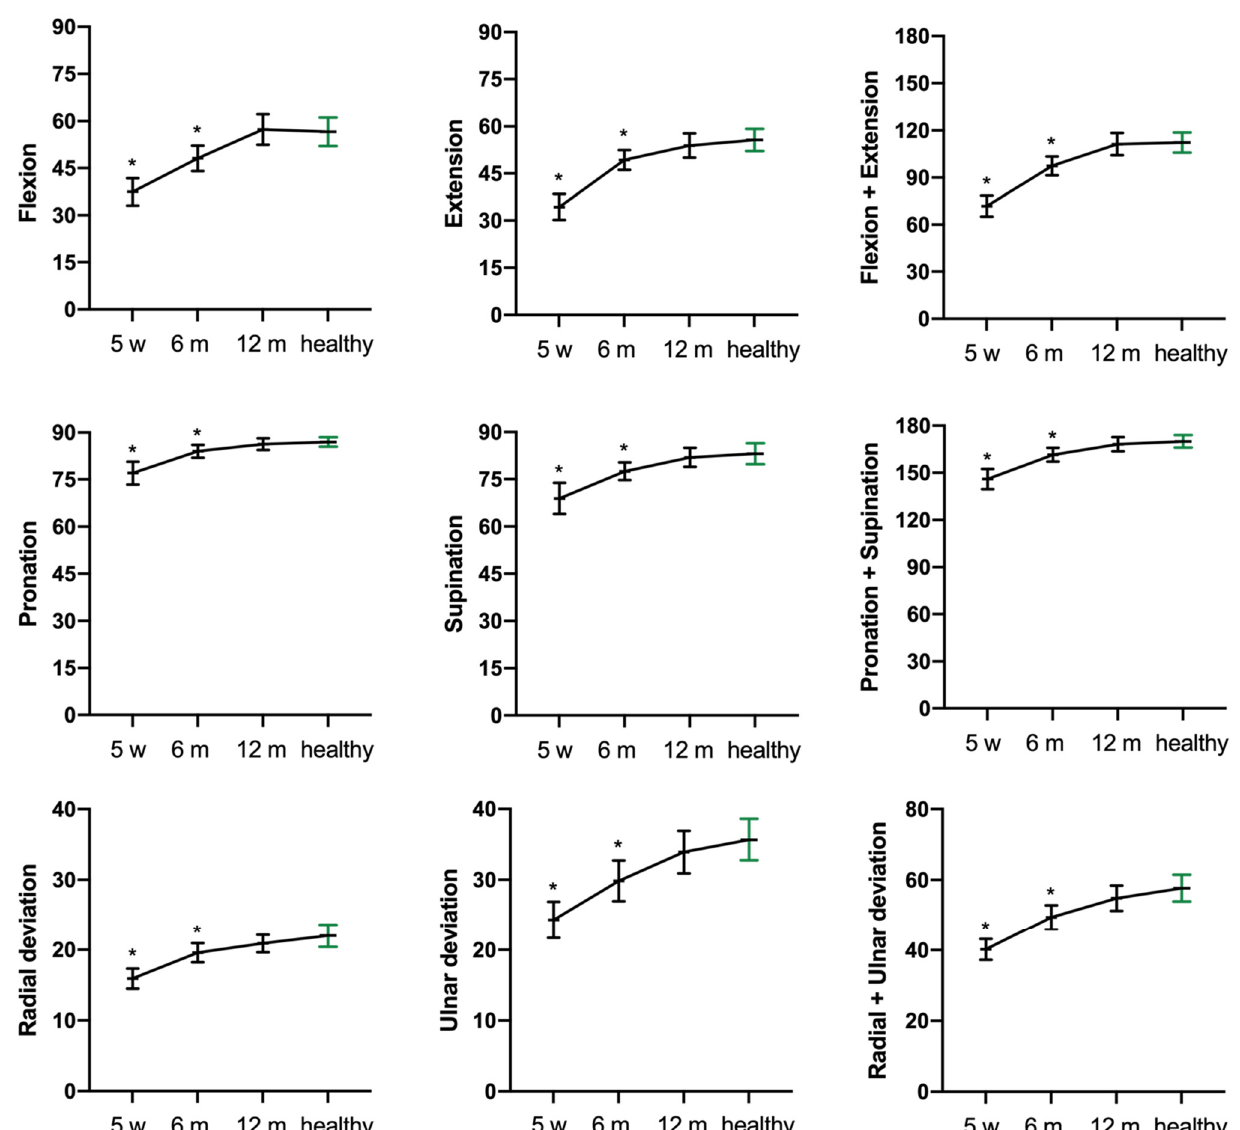
Figure 3. Temporal changes in active range of motion (degrees) after five weeks (w) and six and 12 months (m) compared with the healthy side at 12 months. * p < 0.05 compared with the healthy side (green).